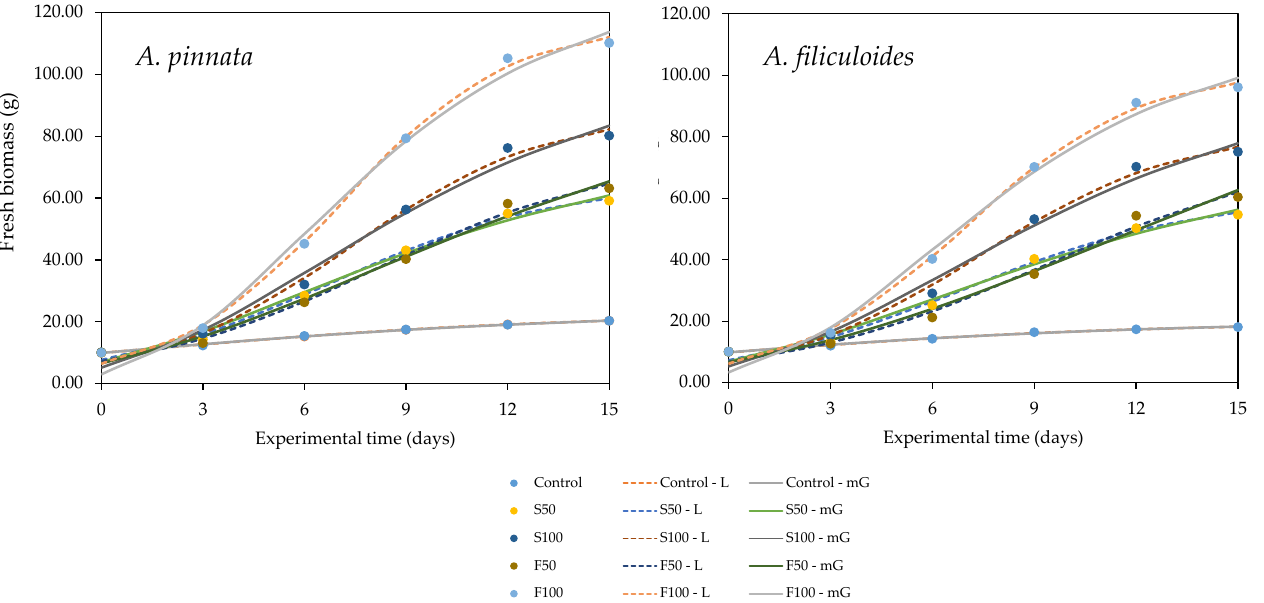
Figure 4. Comparison of experimental and predicted (S: stagnant; F: flowing reactor; L: logistic; mG: modified Gompertz) growth curves of two Azolla spp. cultivated in different treatments of MFW.